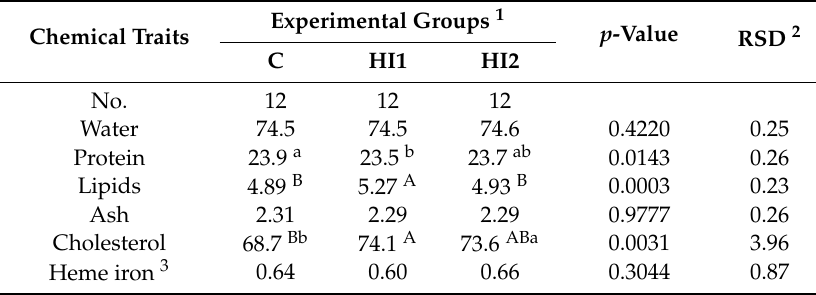
Table 3. E ff ect of the dietary inclusion of Hermetia illucens dried larvae farmed on di ff erent growth substrates (HI1, HI2) on the proximate composition (%), cholesterol, and heme iron contents (mg / 100 g meat) of broiler quails’ breast